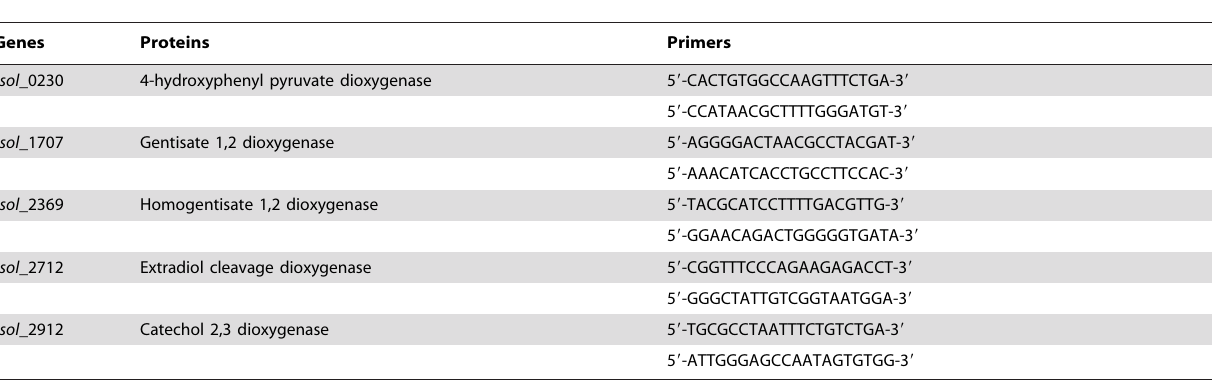
Table 1. Primers used in gene-expression analyses in S. solfataricus